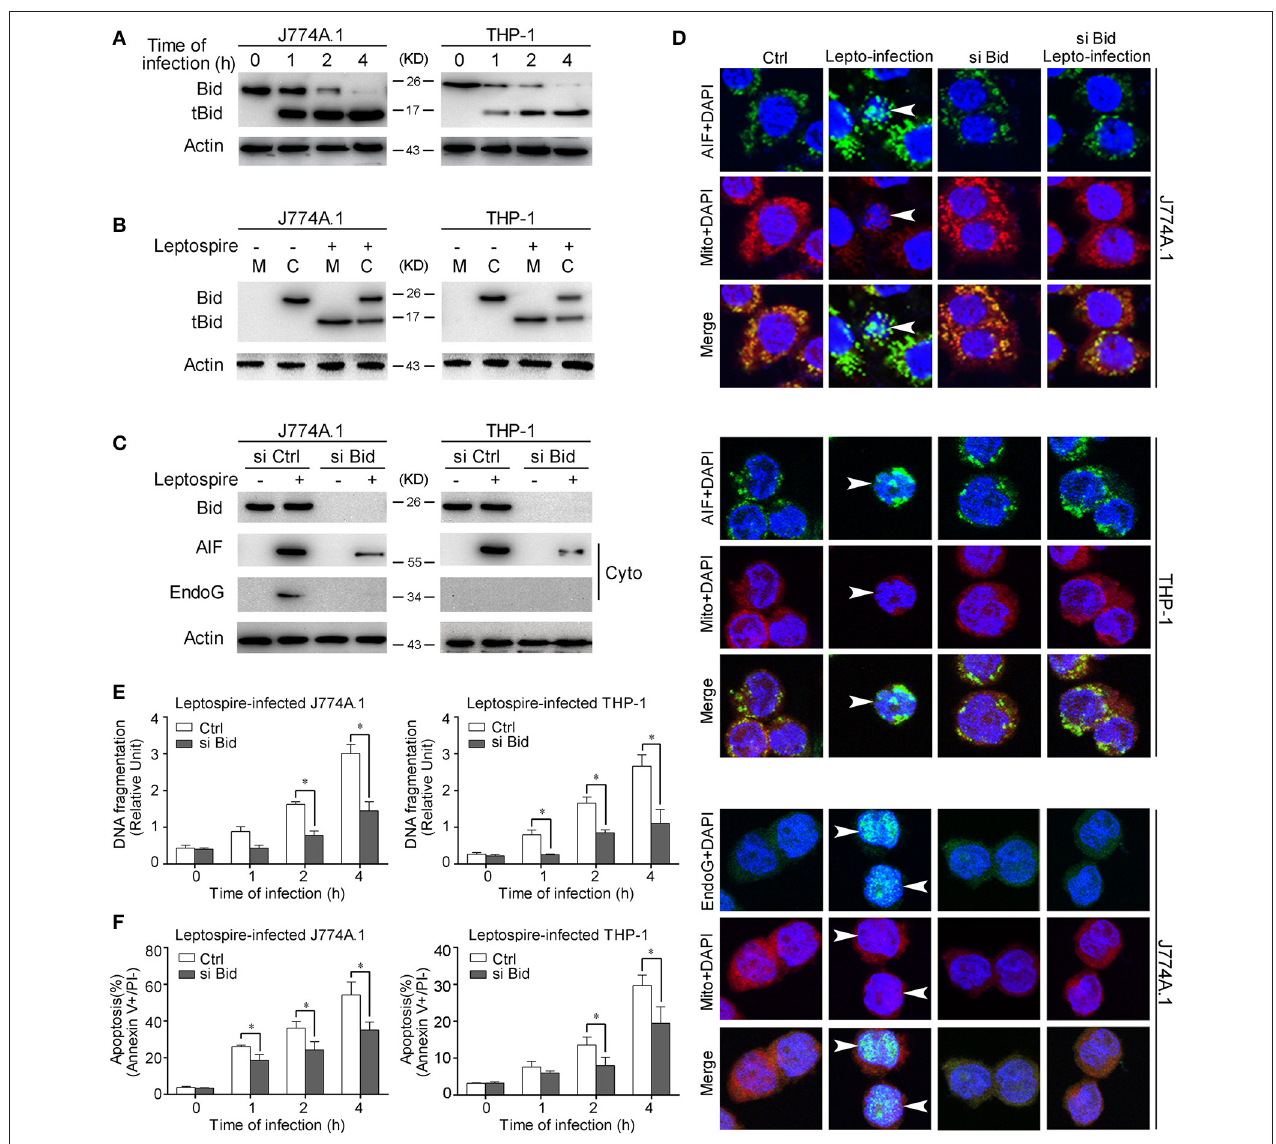
FIGURE 4 | Bid activation mediates the release and nuclear translocation of AIF, EndoG, and the subsequent DNA fragmentation and apoptosis. (A) The activation of Bid in the macrophages infected with leptospires at the indicated times. (B) The subcellular location of Bid and tBid during infection. Macrophages were infected with leptospires for 4h and subjected to subcellular fractionation. The mitochondrial (M) or cytosolic (C) fractions were immunoblotted for Bid and tBid. (C) The reduction of the release of AIF and EndoG from mitochondria in si Bid pretreated macrophages during the infection. Macrophages were transfected with si Bid or Ctrl siRNA, and then infected with leptospires for 4h. (D) The reduction of the nuclear translocation of AIF and EndoG in si Bid pretreated macrophages during the infection. Macrophages were transfected with si Bid or Ctrl siRNA, and then infected with leptospires for 4h. Arrows: AIF or EndoG nuclei translocation. (E) The reduction of the DNA fragmentation in si Bid pretreated macrophages during the infection. Cells pretreated with Ctrl siRNA or si Bid were infected with leptospires for the indicated times. Bars show the mean ± SD of three independent experiments. * p < 0.05 for comparison with the Ctrl siRNA. (F) The reduction of the apoptosis in si Bid pretreated macrophages during the infection. Cells pretreated with Ctrl siRNA or si Bid were infected with leptospires for the indicated times. Bars show the mean ± SD of three independent experiments. * p < 0.05 for comparison with the Ctrl siRNA. Representative results of three experiments with consistent results are shown.